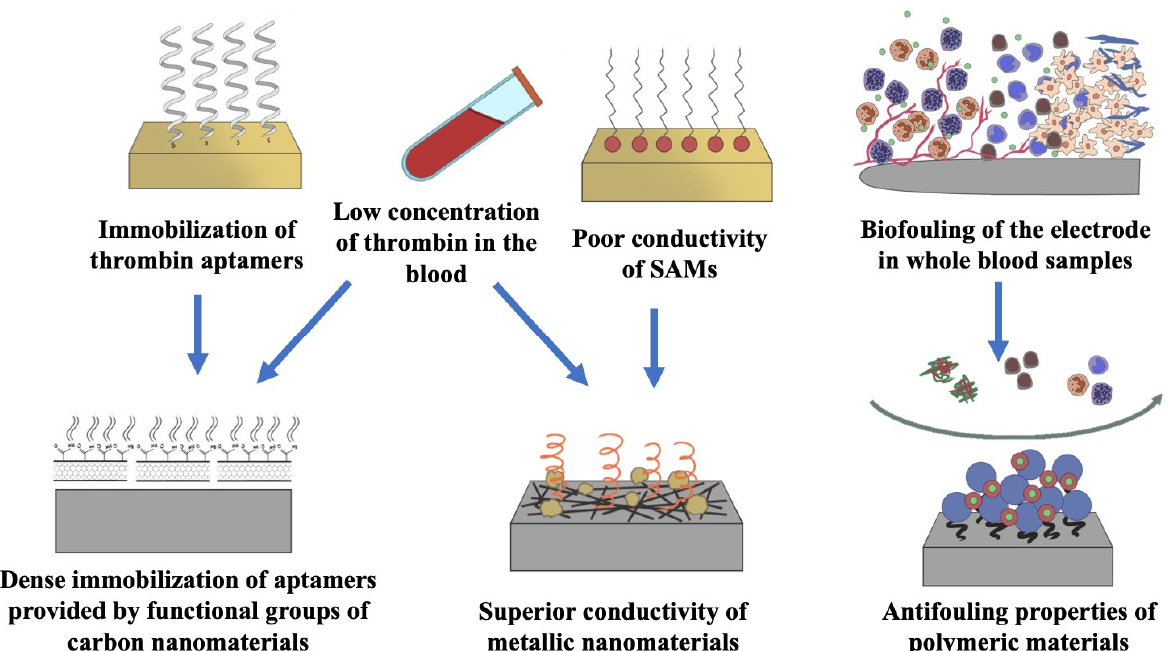
Figure 1. Immobilization of aptamers, low concentration of thrombin in the blood, poor conductivity of SAMs, and biofouling of electrodes in whole blood are the main challenges in the electrochemical detection of thrombin. These issues and problems could be resolved by utilizing nanomaterials and nanostructures.